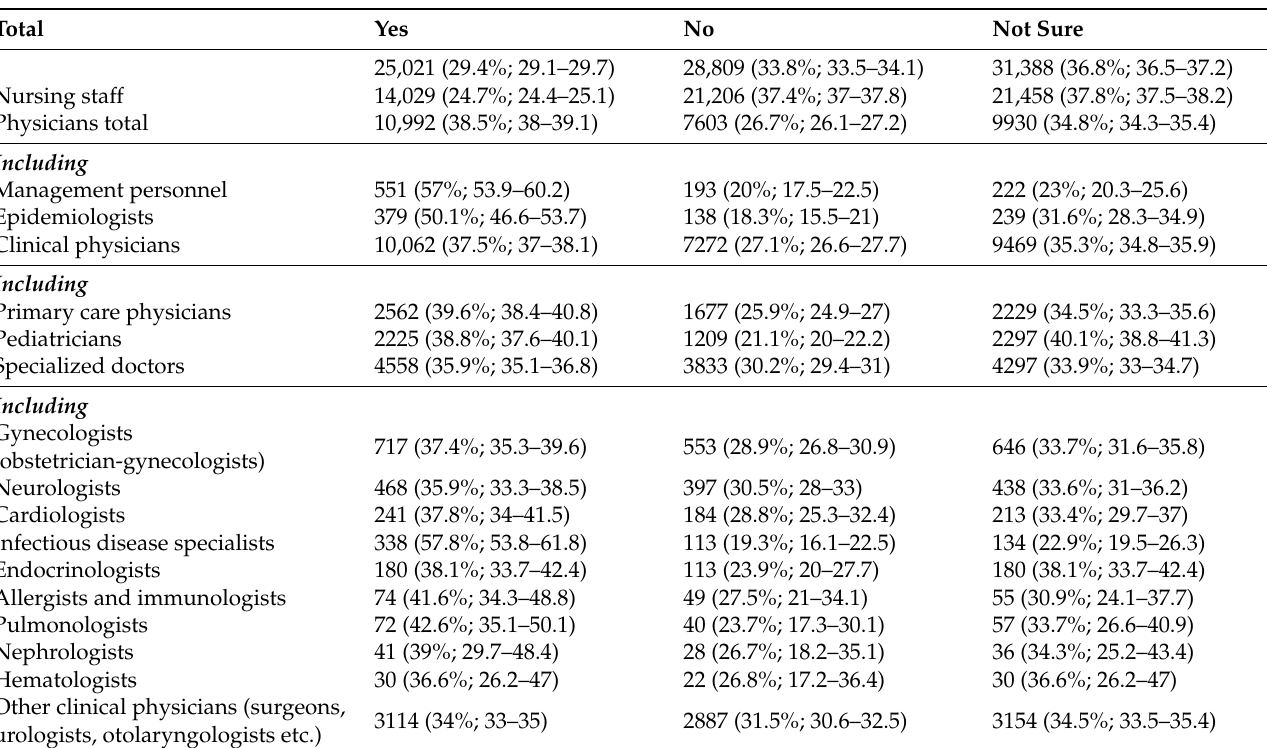
Table A4. Question: “Are you ready to recommend vaccination against COVID-19?” (specialty). Absolute value, proportion and 95% confidence interval. p < 0.001.